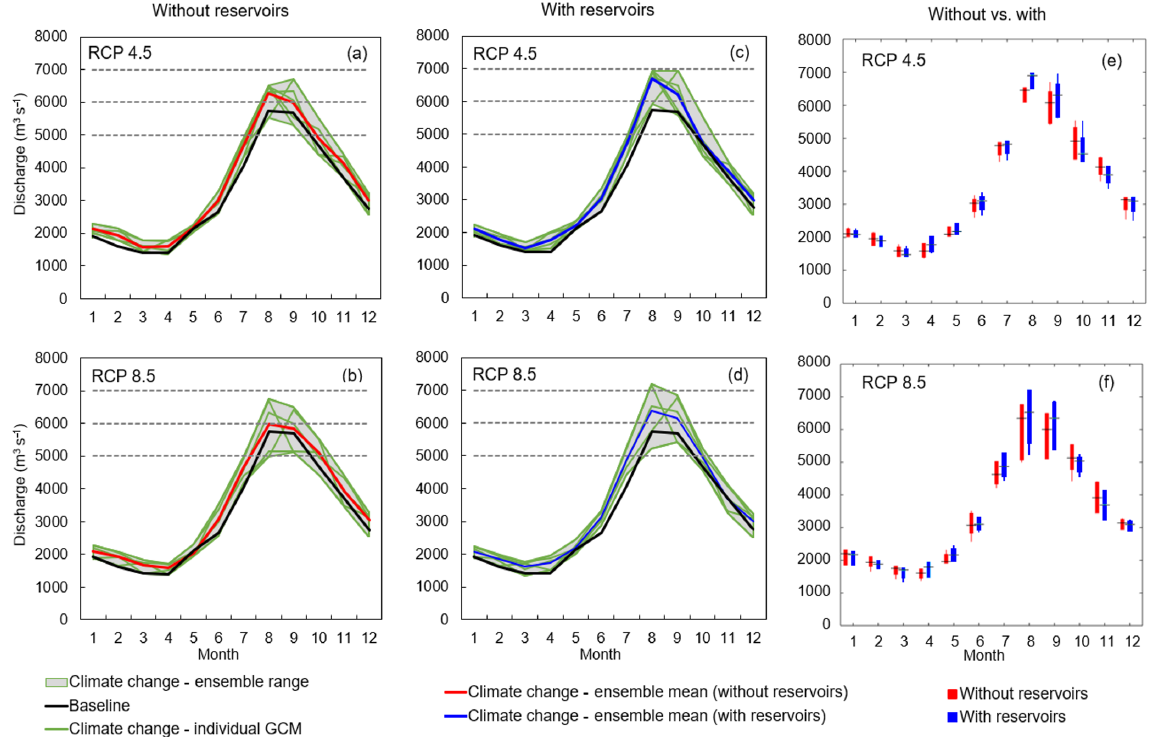
Figure 10. Projected monthly discharges at Chiang Saen under five GCMs and two RCPs for the two selected models calibrated without and with reservoirs (a–d) . Box plots highlighting the variability in monthly discharges predicted by the two models under RCP 4.5 (e) and RCP 8.5 (f)